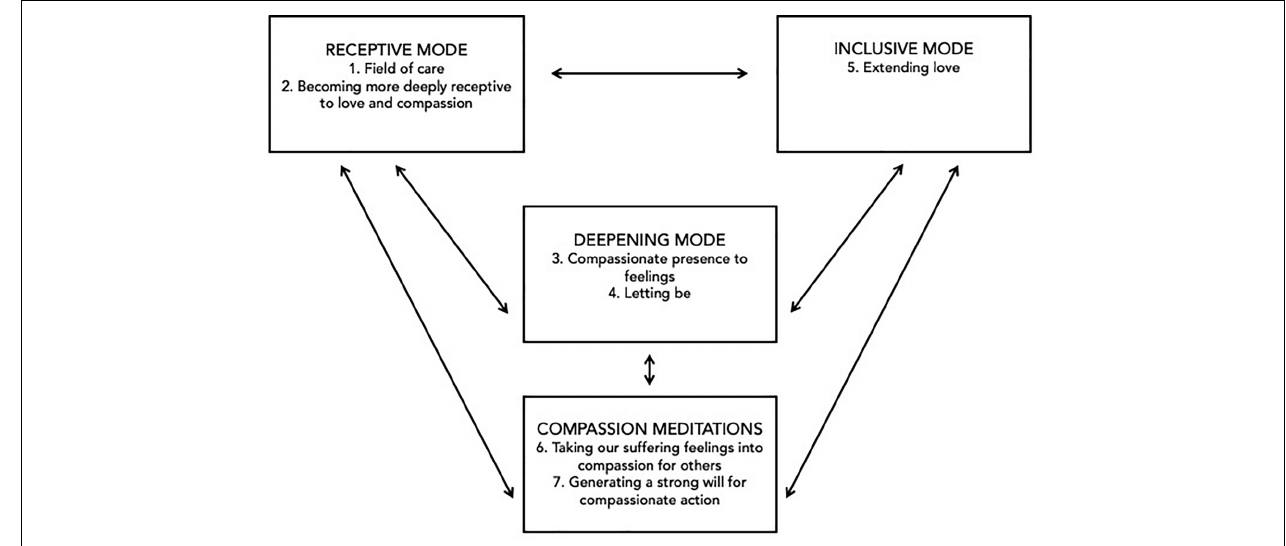
FIGURE 1 | Sustainable Compassion Training